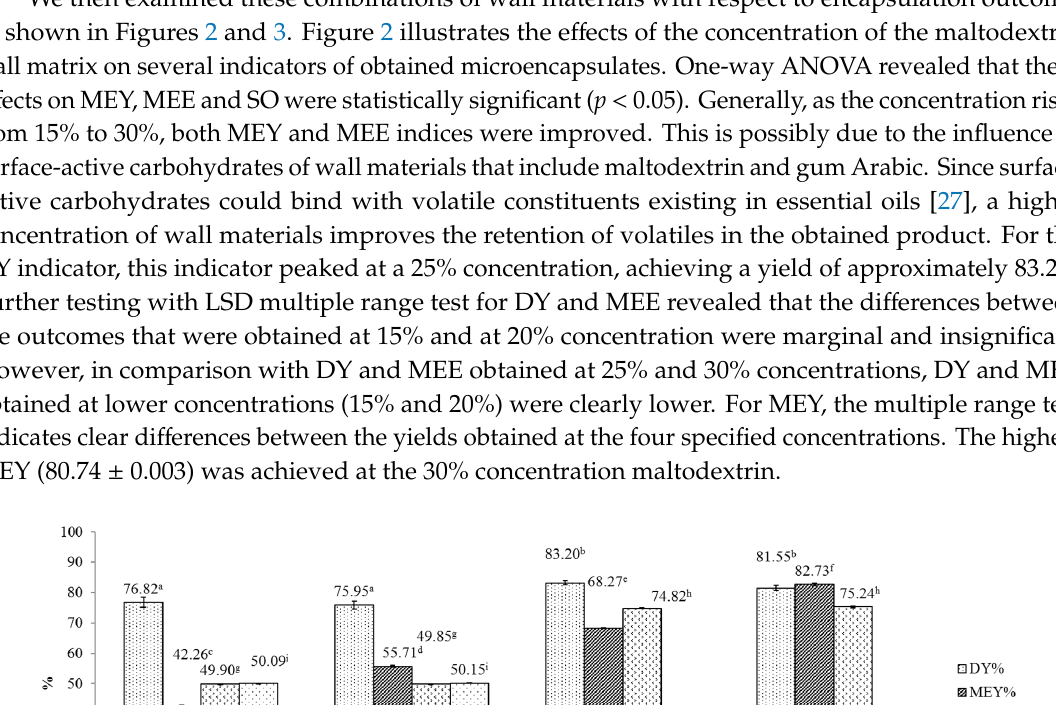
Figure 3. Effect of maltodextrin:gum Arabic mixture (4:1) concentration on various indicators of the microencapsulation process. Figures with same letters indicate statistical indifference Comparing the DY in the two investigations, we found that the use of maltodextrin gave better yields than the use of combined wall materials. Although the average DY reached 82.75% in the experiment that utilized combined wall materials at a concentration of 30%, that figure was highly variable, as reflected by the large standard deviation. On the other hand, the use of sole maltodextrin produced consistently high DY regardless of maltodextrin concentration, ranging from 76.82 to 83.20%. This could be explained by the higher required air temperature for encapsulation with the maltodextrin:gum Arabic walling mixture. To be specific, the high inlet air temperature (200 °C) may cause a caramelization reaction to occur, producing furans, furanones, pyrones and carbocyclics and reducing drying yields, as suggested by a previous study [29]. Considering the lower cost of maltodextrin in comparison with that of gum Arabic and MEY and MEE results, sole maltodextrin at the concentration of 30% would be used in subsequent experiments. 3.3. Effect of Concentration of the Core Material